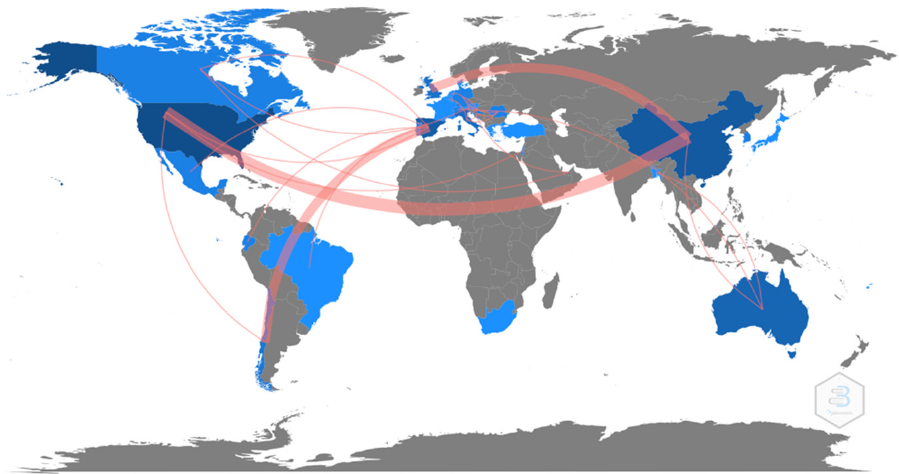
≥ 1 collaboration).